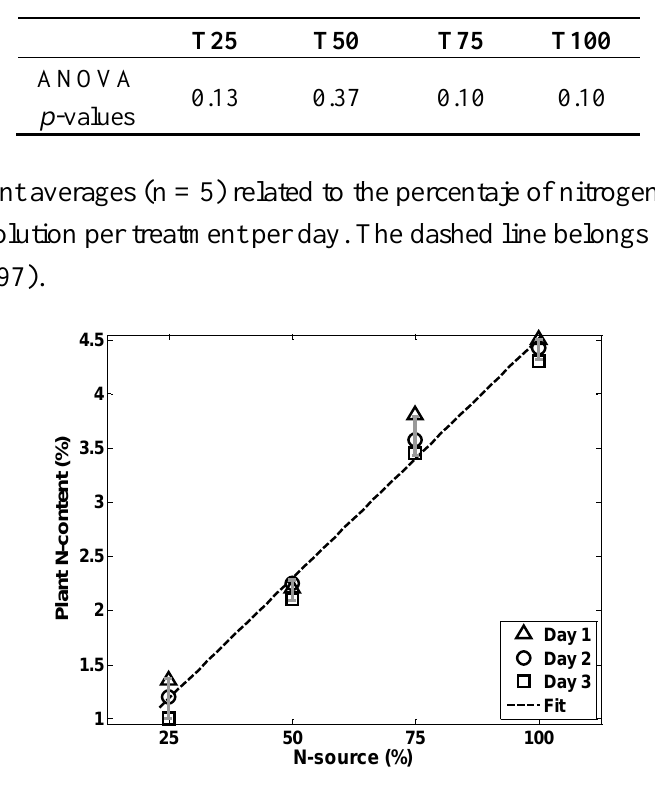
Table 3. Statistical analysis of N-content data: one-way ANOVA between days per treatment.